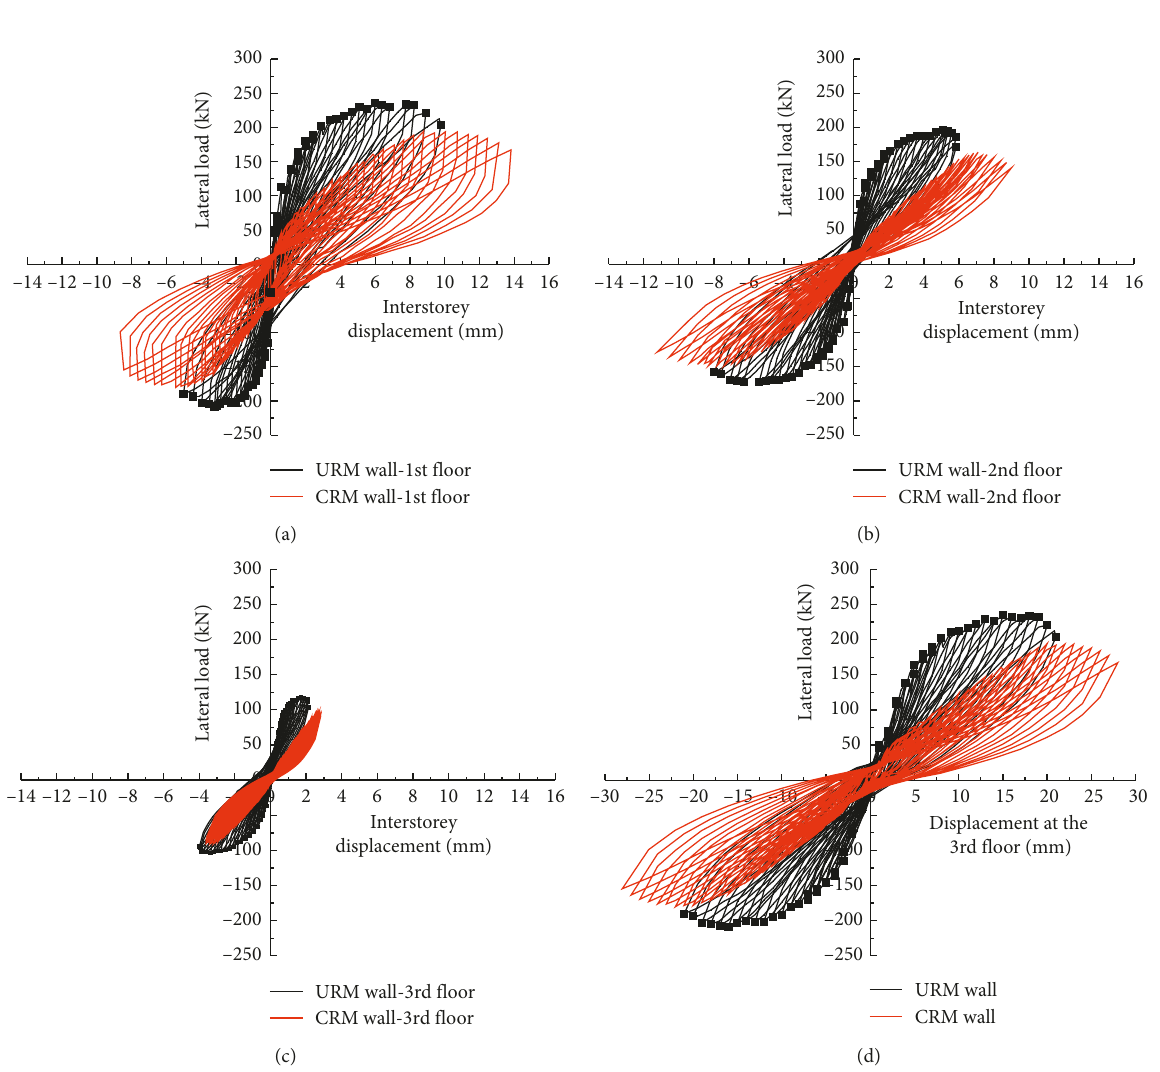
Figure 10: Hysteresis curves of the URM and CRM walls. (a) Hysteresis curves of 1st the floor. (b) Hysteresis curves of the 2nd floor. (c) Hysteresis curves of the 3rd floor. (d) Hysteresis curves of the entire